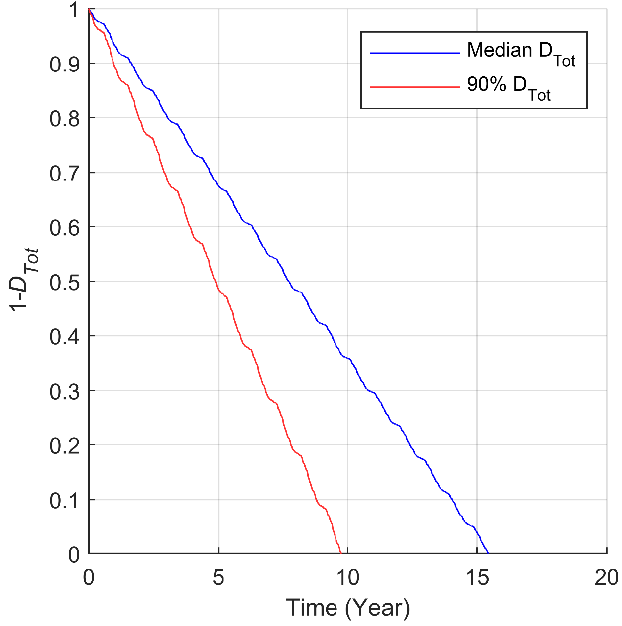
Figure 15. Graphic of 1 − D Tot for WT n°8. In blue, the median D Tot , computed with the 50th percentile of D HCF . In red, 90% D Tot , computed with the 90th percentile of D HCF .